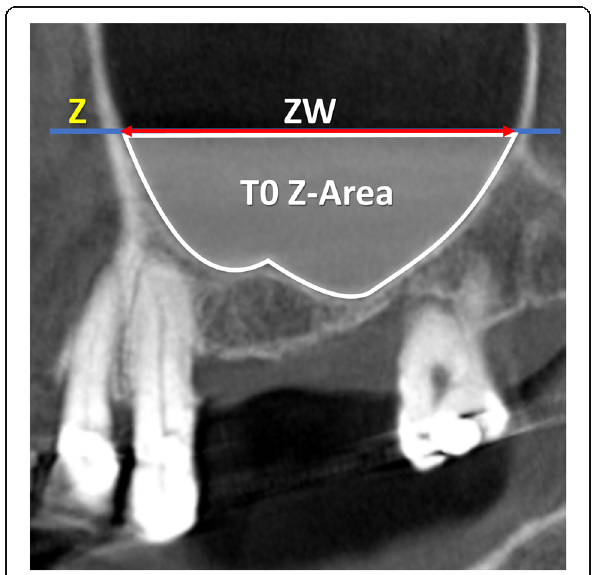
Fig. 2 T0, lateral view of a no-membrane CBCT; Z, line drawn following the floor of the nose; ZW (sinus extension), distance evaluated on the line Z between the two intersection points with the mesial and distal sinus bone walls; T0 Z-Area, area delimited by the sinus bone walls and the line Z